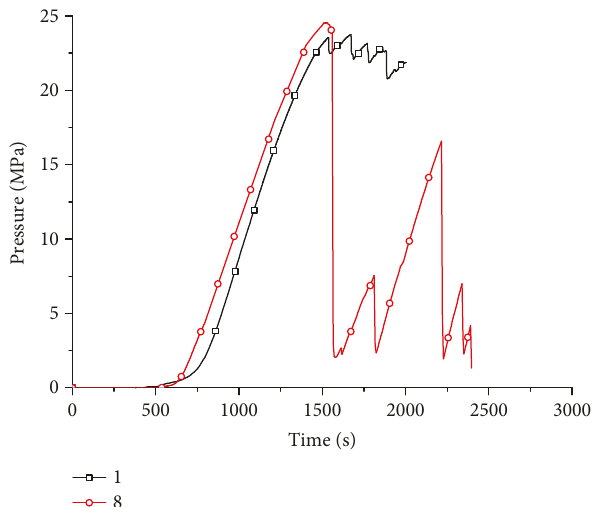
Figure 16: Pressure curves in the core fracturing process.